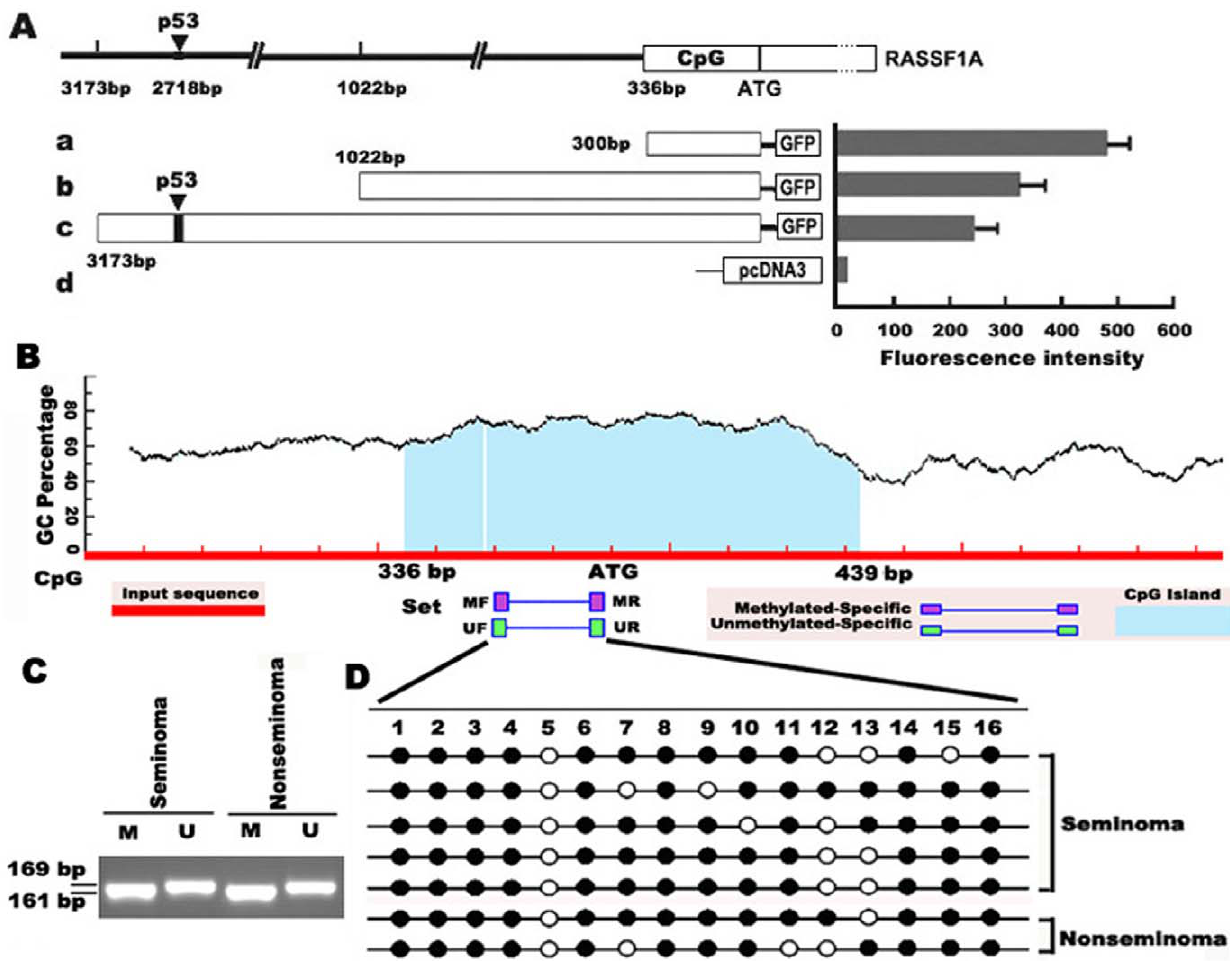
Figure 1. Promoter activity and methylation analysis of RASSF1A in human testis cancer. A , RASSF1A promoter activity by GFP expression under the control of different length of RASSF1A promoter segments. A predicted p53 binding site in RASSF1A promoter ( 2 2718 bp) was showed in the construction c. B , CpG island prediction of RASSF1A by software MethPrimer online (http://www.urogene.org/methprimer/). Predicted CpG island is indicated by blue color. C , Representative results of the methylation-sensitive PCR (MSP) analysis of RASSF1A in both seminoma and nonseminoma. M, MSP PCR; U, unmethylation-sensitive PCR. D , DNA methylation status of individual CpG sites by sodium bisulfite sequencing analysis. Black and white circles represent methylated and unmethylated CpGs